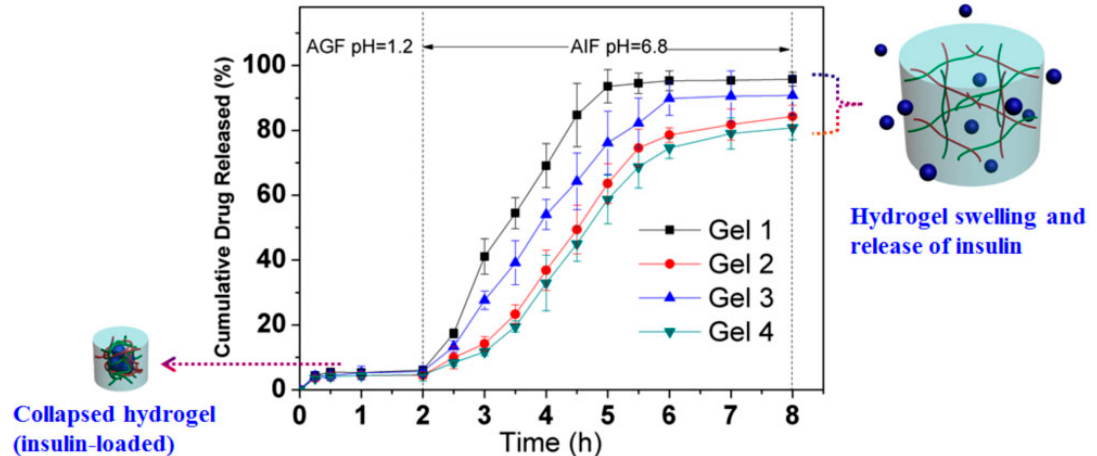
Figure 8. In vitro release profiles of insulin from hydrogels after incubation of insulin-loaded gels in artificial gastric fluid (AGF) for 2 h at 37 ◦ C, followed by incubation in AIF for another 6 h at 37 ◦ C [102].